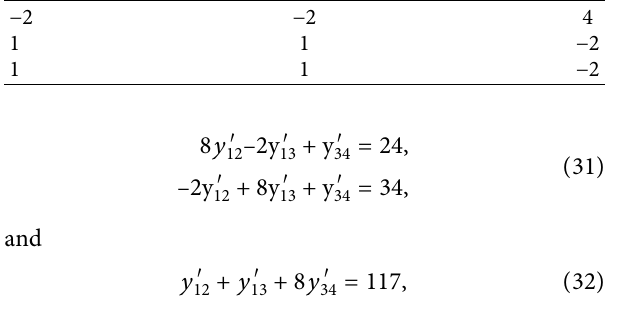
Table 5: Residuals for an additive ft to Table 4 with 9 added to the cell (1, 3).